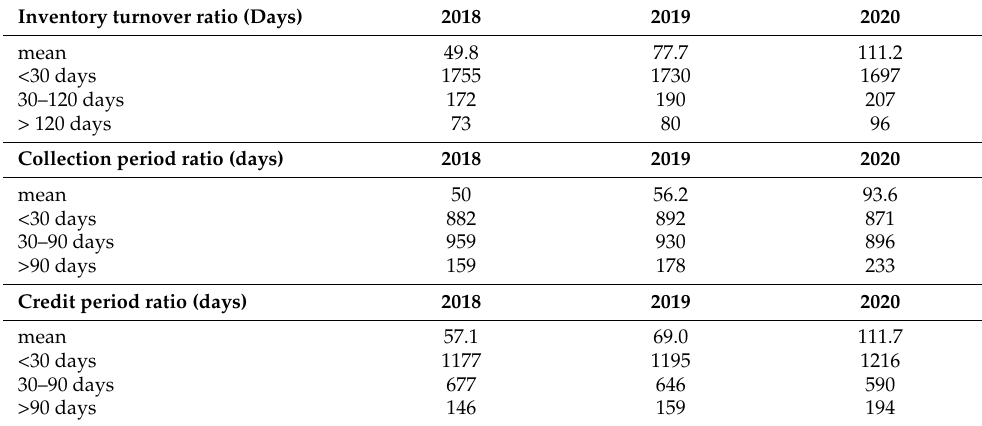
Table 5. Efficiency ratios of the enterprises operating in the construction sector during